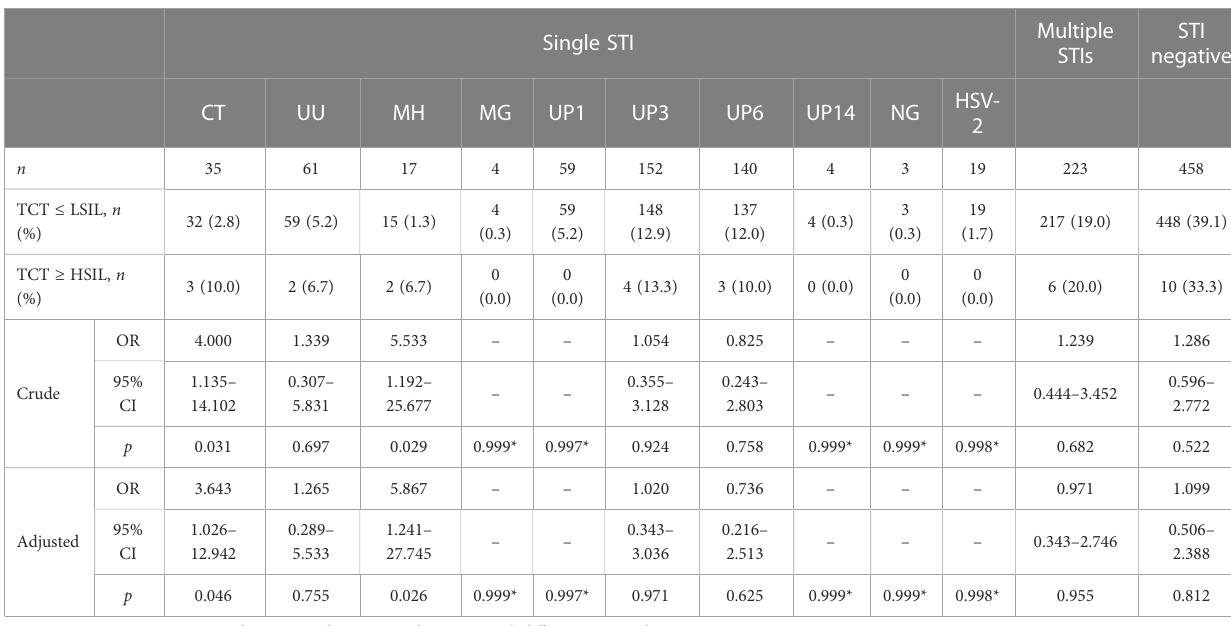
TABLE 5 Infection rates of STIs in groups with different TCT